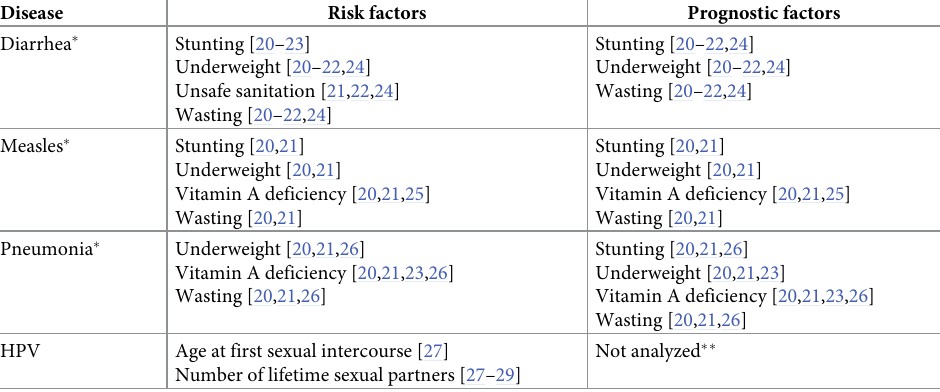
Table 1. Selected risk and prognostic factors for diarrhea, measles, pneumonia, and HPV. See Section 3 of S1 Text for more detailed methodology on risk factor selection.